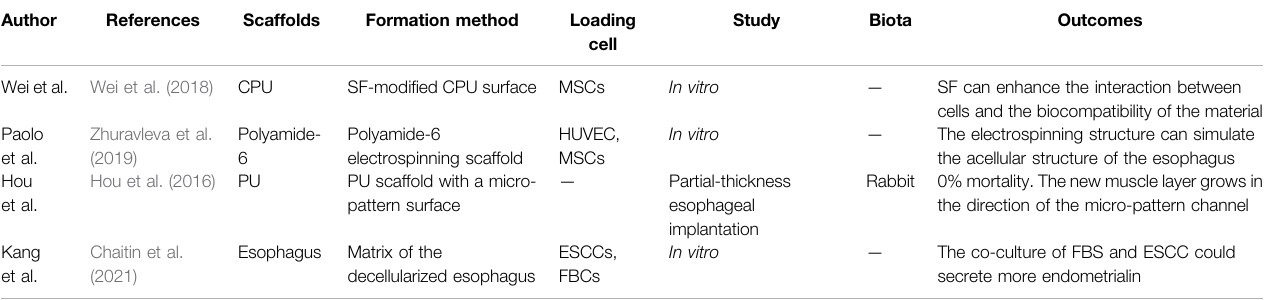
TABLE 2 | Classi fi cation according to the construction of single-layer